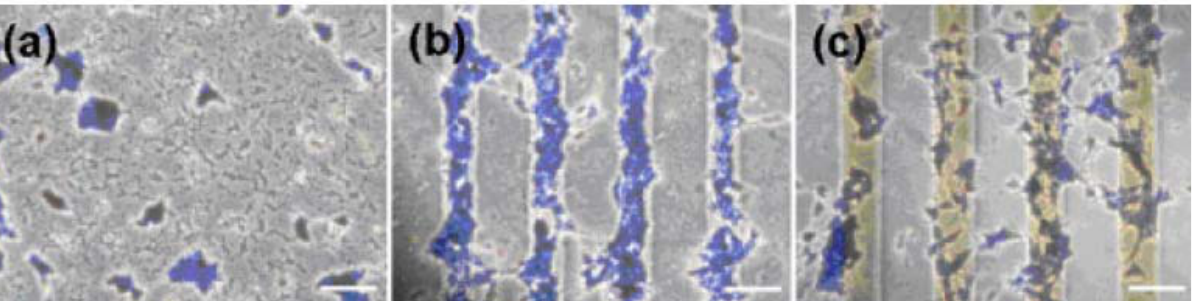
Figure 15. Optical microscope images of the cell patterns on PVC surfaces irradiated with ion beam at ( a ) 1 × 10 14 ; ( b ) 1 × 10 15 ; and ( c ) 1 × 10 16 ions/cm 2 . Each scale bar represents 100 nm (Reprinted with permission from [67]. Copyright 2010